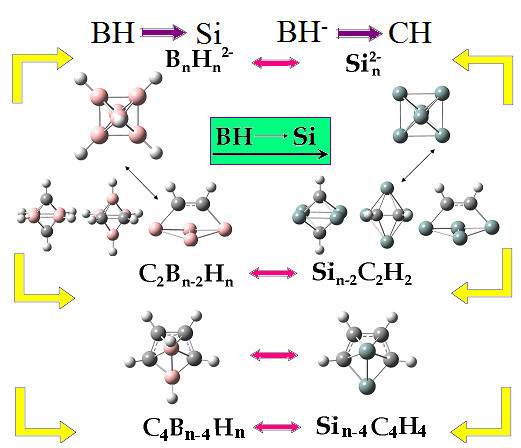
Schematic illustration of the SiC- extended boron connection. Isolobal analogy of Sin2-, (BnHn) 2-, Sin-2C2H2, C2Bn-2Hn, including the Sin-4C4H4 and C4Bn-4Hn similarity.